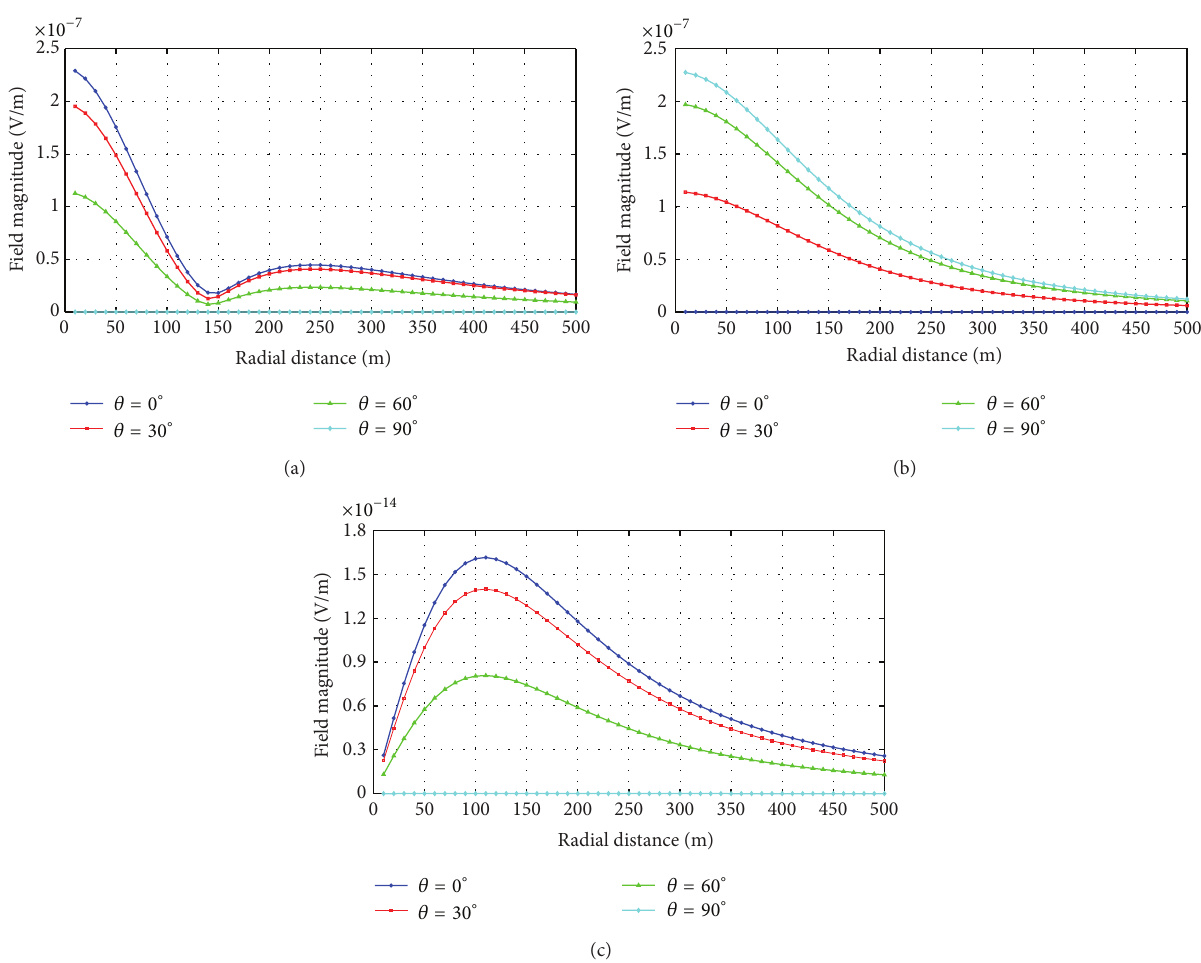
Figure 3: Curves of (a) the radial component of the electric field magnitude, (b) the tangential component of the electric field magnitude, and (c) the axial component of the electric field magnitude with the radial